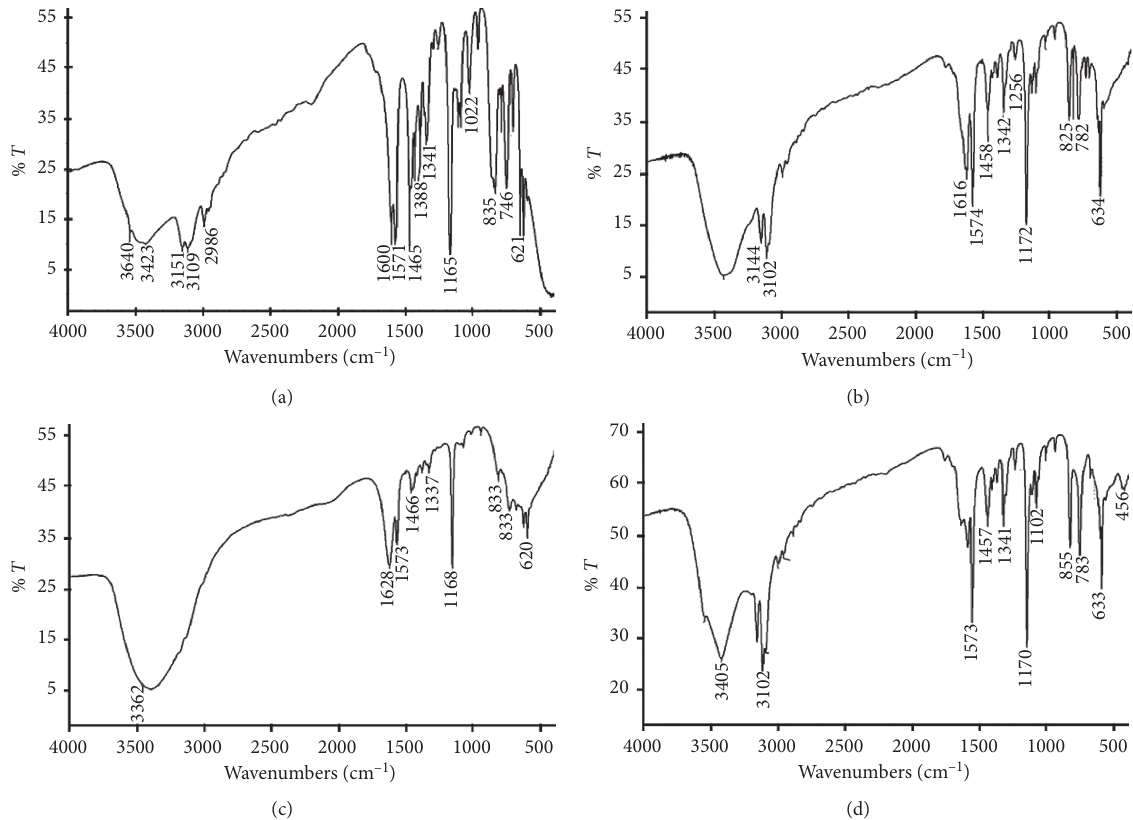
Figure 2: FT-IR spectra of (a) [EMIM-Cl][FeCl 2 ], (b) [EMIM-Cl][MnCl 2 ], (c) [EMIM-Cl][NiCl 2 ], and (d) [EMIM-Cl][CoCl 2